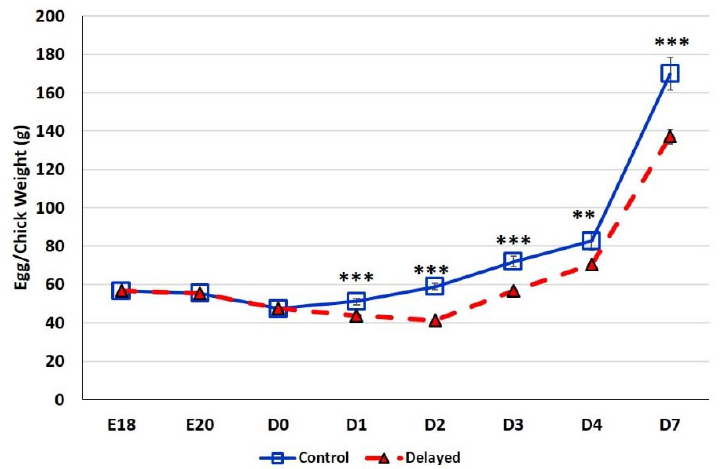
Figure 1. Body weight gain (g) of fed from hatch and delayed fed broiler chicks. For uniformity, eggs were weighed prior to blood collection therefore at embryonic days (E) E18 and E20 mean egg weights are provided (n = 6 males). At day hatch (D) D0–D7, chick mean weights are provided (n = 6 males/treatment). Error bars denote standard deviations. Significant ( p < 0.05) differences between treatment groups were determined using analysis of variance. ** p < 0.001, *** p < 0.0001 denote significant differences between fed at hatch chicks and chicks with delayed access to feed for 48 h.